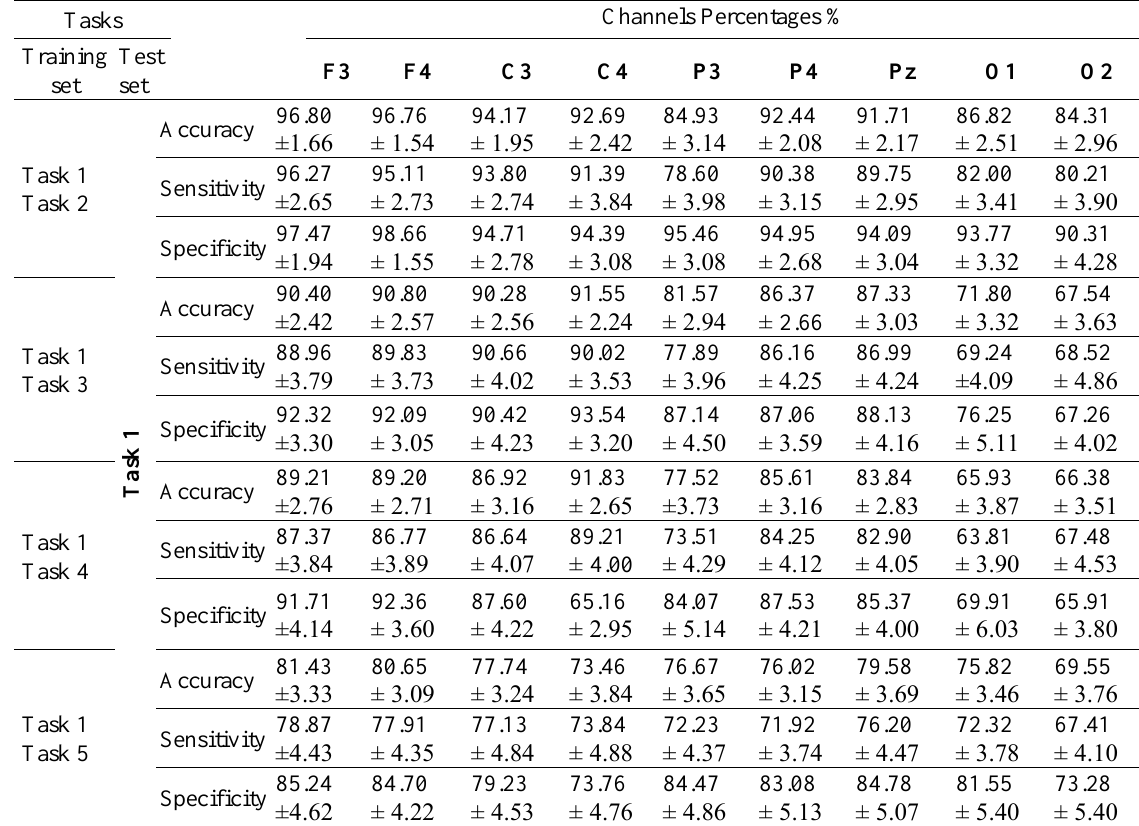
Table 8 . Accuracy, Sensitivity and Specificity values for a two-class